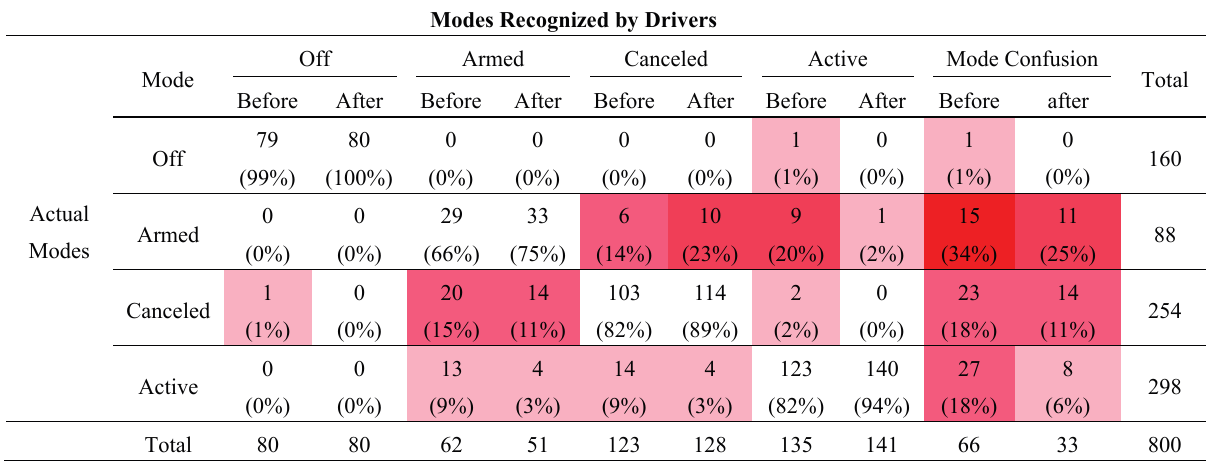
Table 9. Mode confusion rates before and after glancing at the four-mode interface in the experiments.